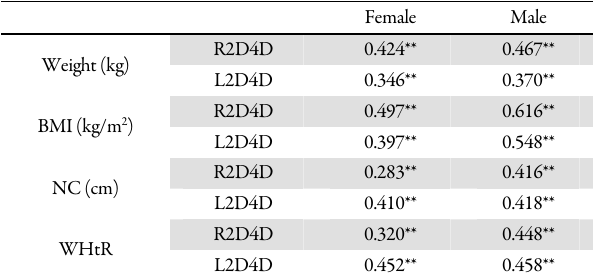
Table 3. The coefficient of correlation in anthropometric traits and